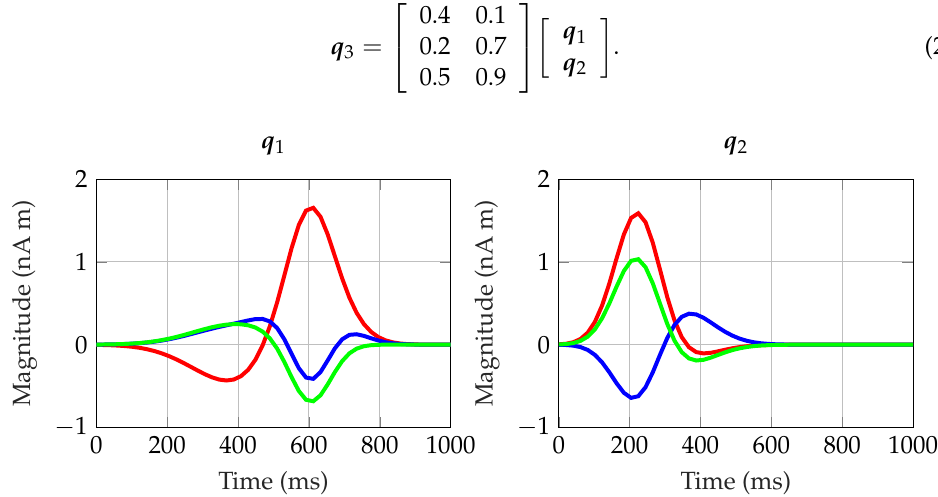
Figure 3. Temporal evolution of dipoles q 1 and q 2 . Their Cartesian components x , y , and z are shown in red, blue, and green,